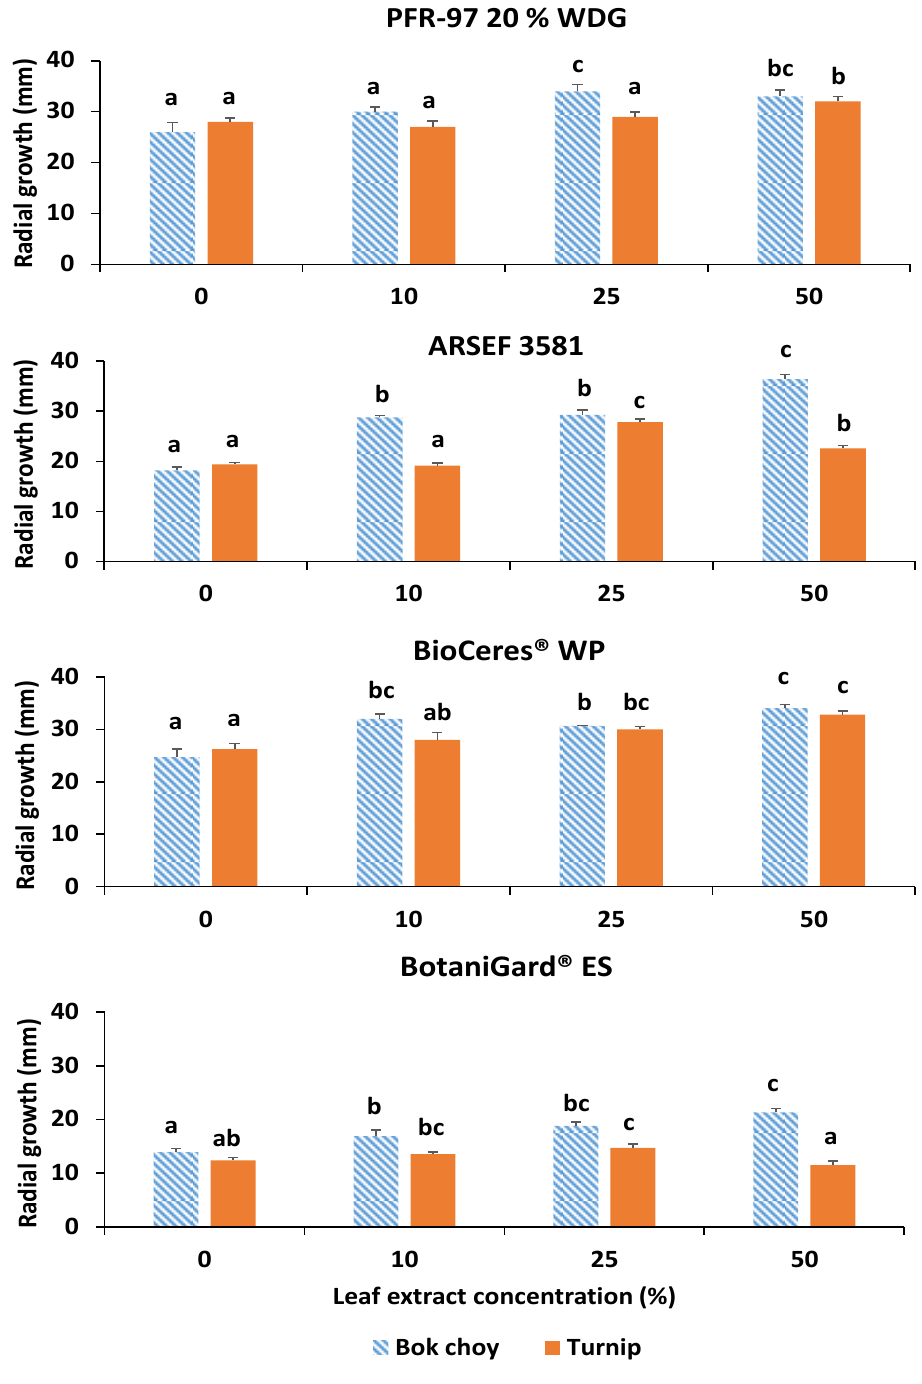
Figure 2. Mean ( ± SE) 15 d fungal radial growth (mm) from four entomopathogenic fungal products grown on PDA with four leaf extract concentrations from bok choy or turnip. For each product, bars for each leaf extract plant source (same color) with different letters are significantly different (Tukey’s HSD test, p < 0.05).